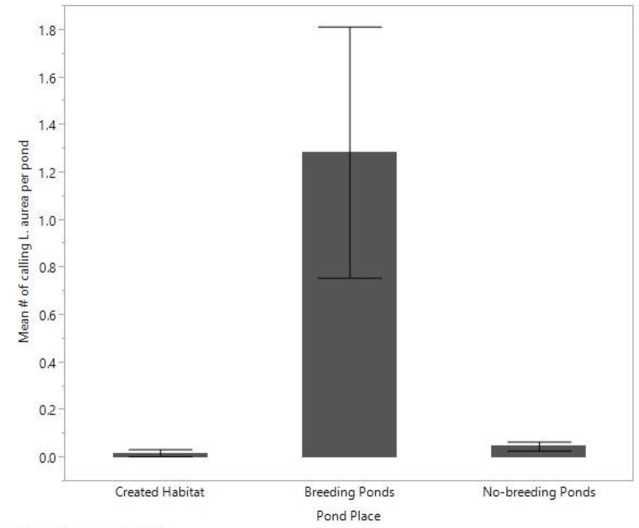
Mean number of L. aurea heard calling per pond across each pond place.Error bars represent 95% confidence intervals.